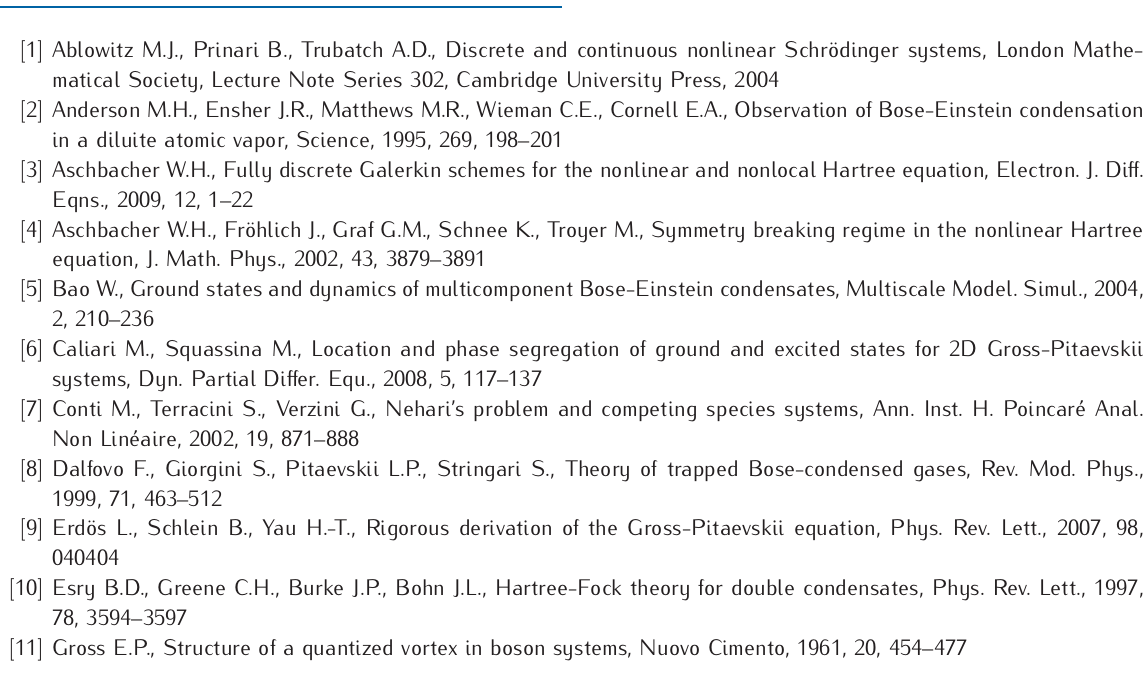
0 [ z κ 1 ,z κ 2 ] as a function of κ